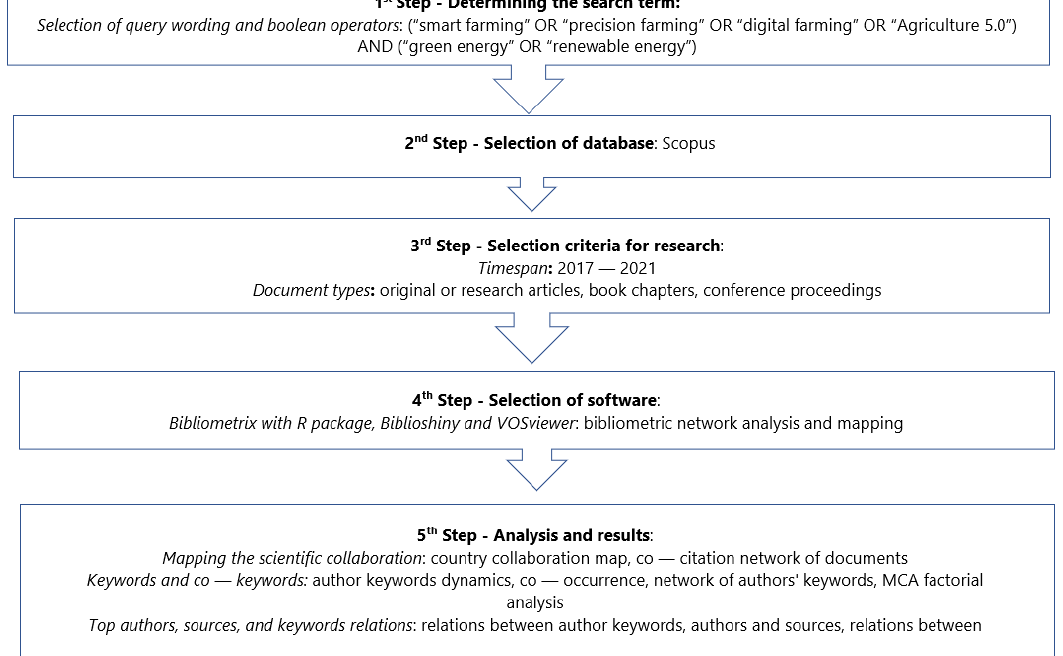
Figure 3. Methodological design for bibliometric process.